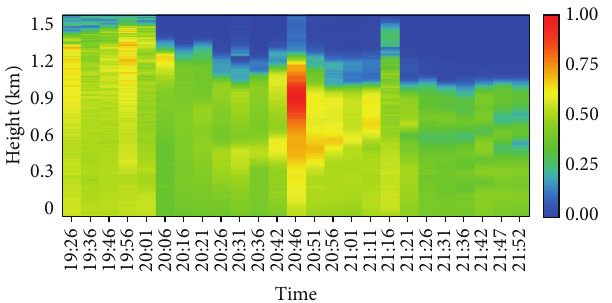
Figure 6: The distribution of aerosol extinction coefficient on March 22.